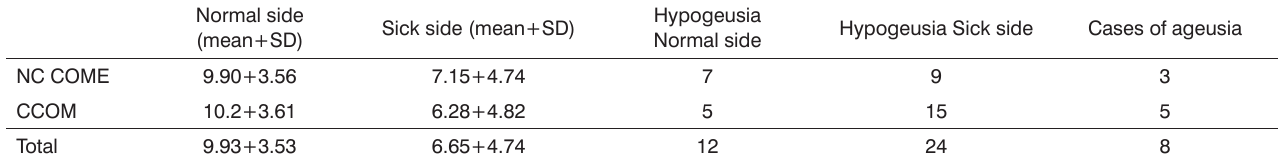
Table 1. Results from the gustatory tests, average of correct answers and number of patients with hypogeusia or ageusia in each side. Normal side